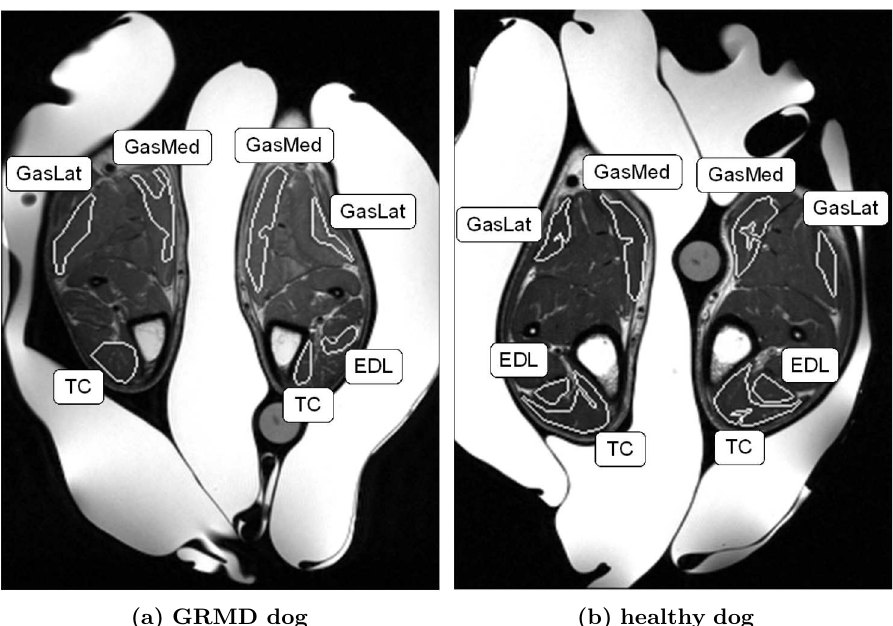
Figure 1. Examples of T2-weighted MRI images, used in the experiments. The images were acquired on a GRMD dog (a) and one healthy control (b), at the age of 8 months. Delineated ROIs cover the four types of muscles considered in the study: EDL, GasLat, GasMed, and TC. Each of the ROIs has a size larger than 100 pixels